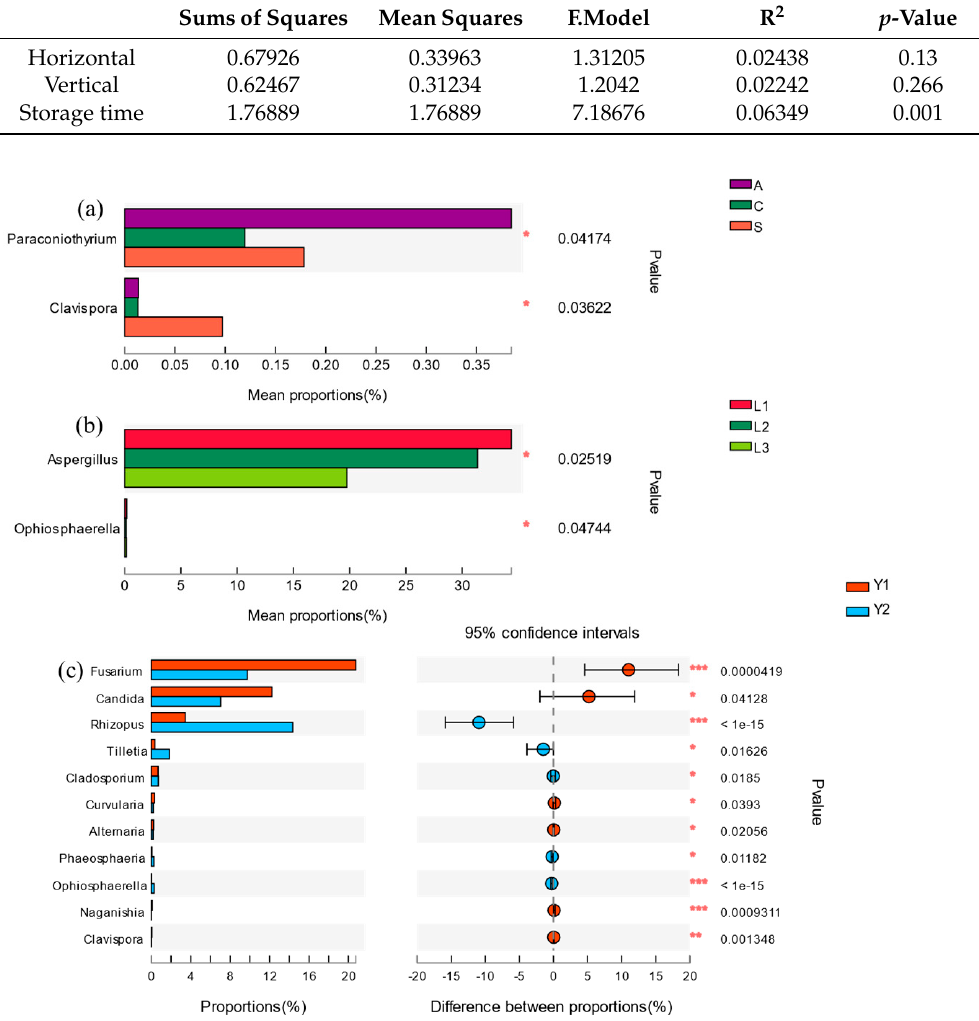
Figure 4. The effect of orientation, position and storage time on the 30 genera with the highest relative abundance. The results of different orientation, vertical position, and storage time effect on fungi are show in ( a ), ( b ) and ( c ),